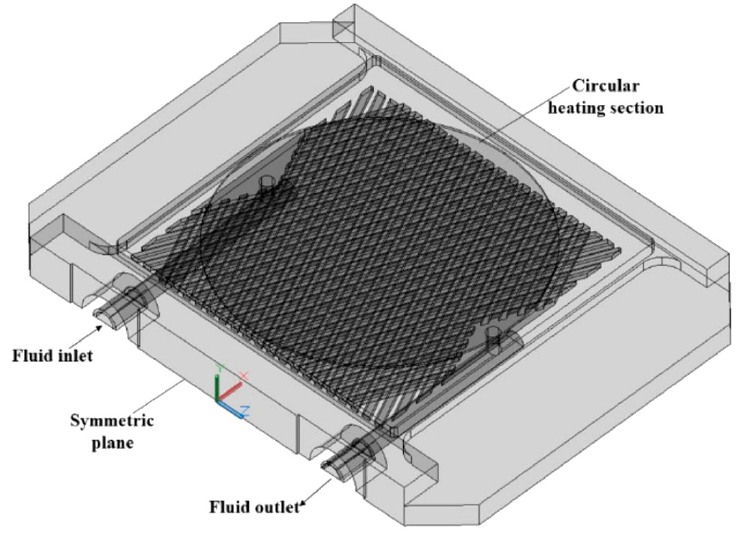
Figure 9. HVDC thyristor heat sink